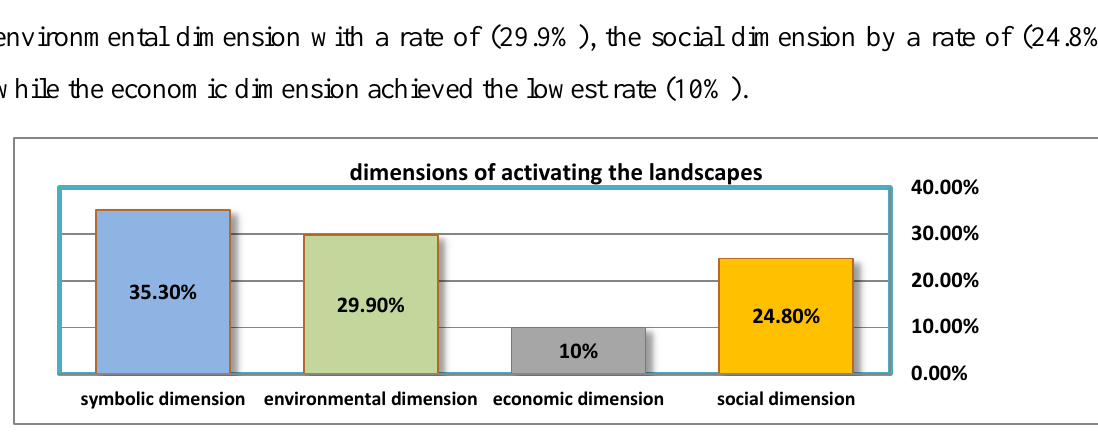
Fig. 18. Results of activation dimensions for the landscapes, (prepared by the